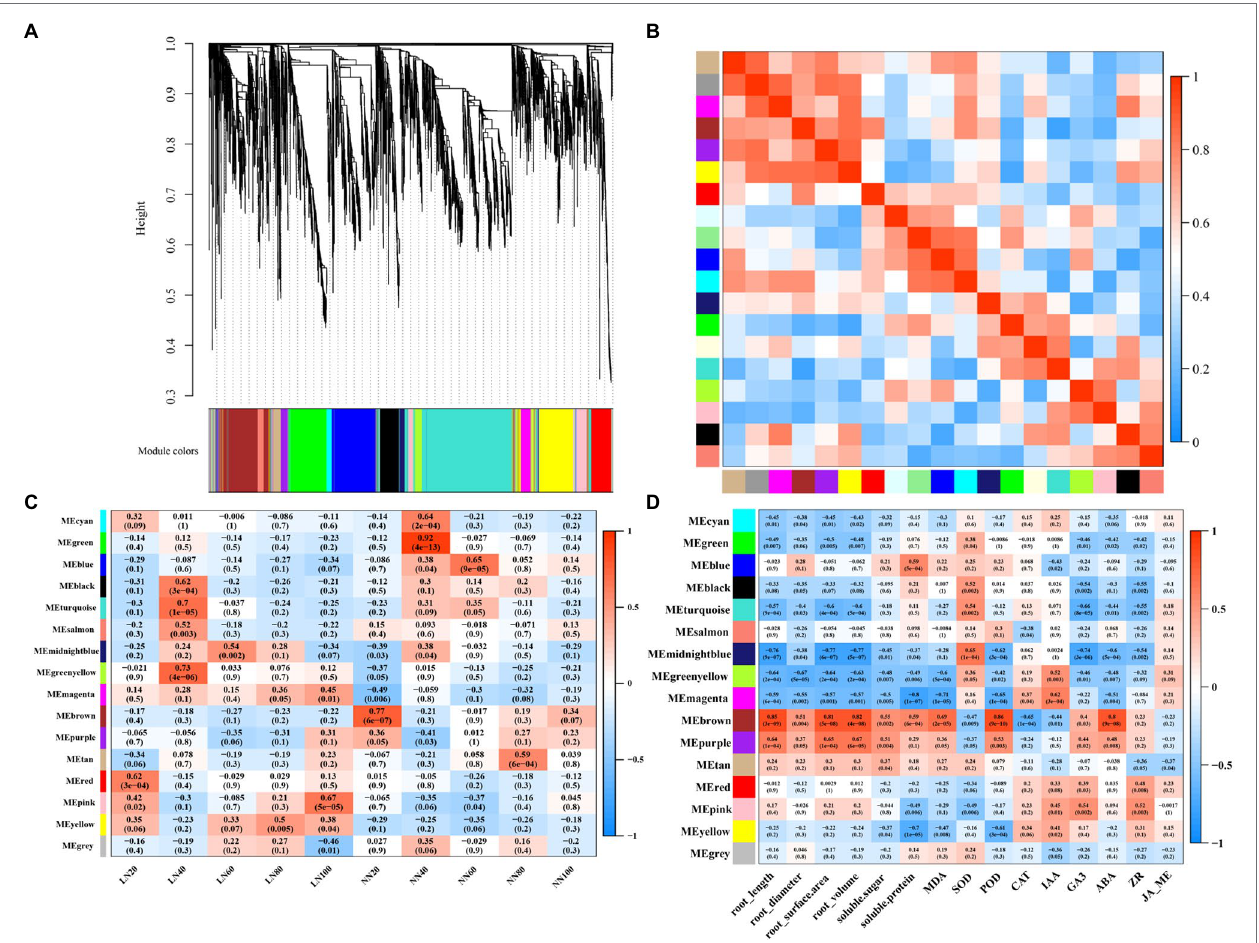
FIGURE 6 | Weighted gene co-expression network analysis (WGCNA) for all DEGs. (A) Clustering diagram of all expressed genes together with assigned module colors, (B) the correlation between modules, (C) the relationship between modules and samples, and (D) the module-trait